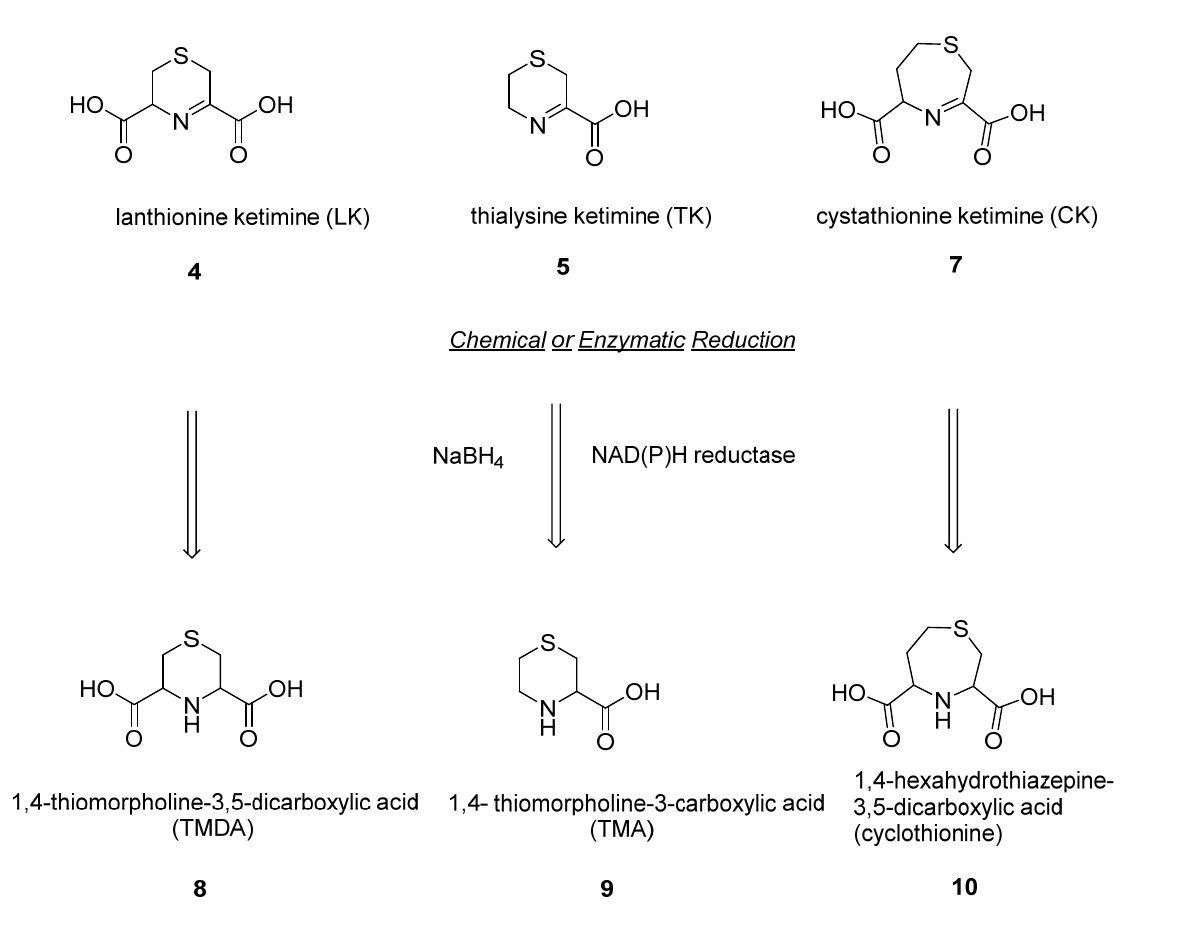
Figure 6. Reduced cyclic sulfur ketimines. These compounds, like their precursors, were found to be produced enzymatically in specific human tissues .